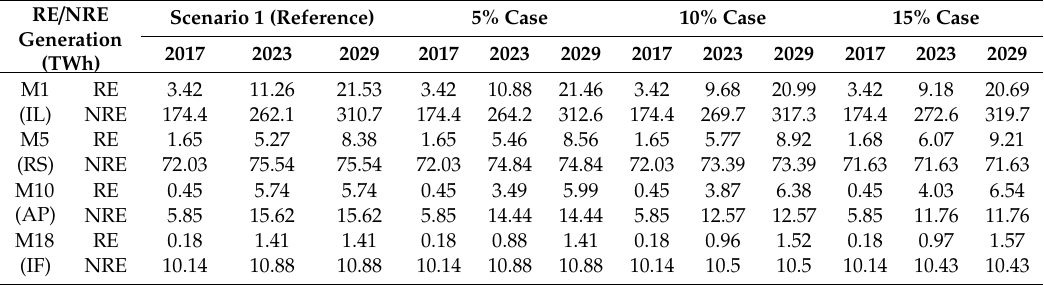
Figure 14. RE / NRE power generation changes with CER price increases in: ( a ) AP segment (M10); ( b ) IL segment (M1); ( c ) IF segment (M18); ( d ) RS segment (M5). Table 8. RE / NRE power generation (TWh) with CER price changes for each segment.